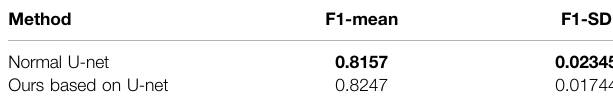
TABLE 6 | Comparison of standard deviations on the F1-score.